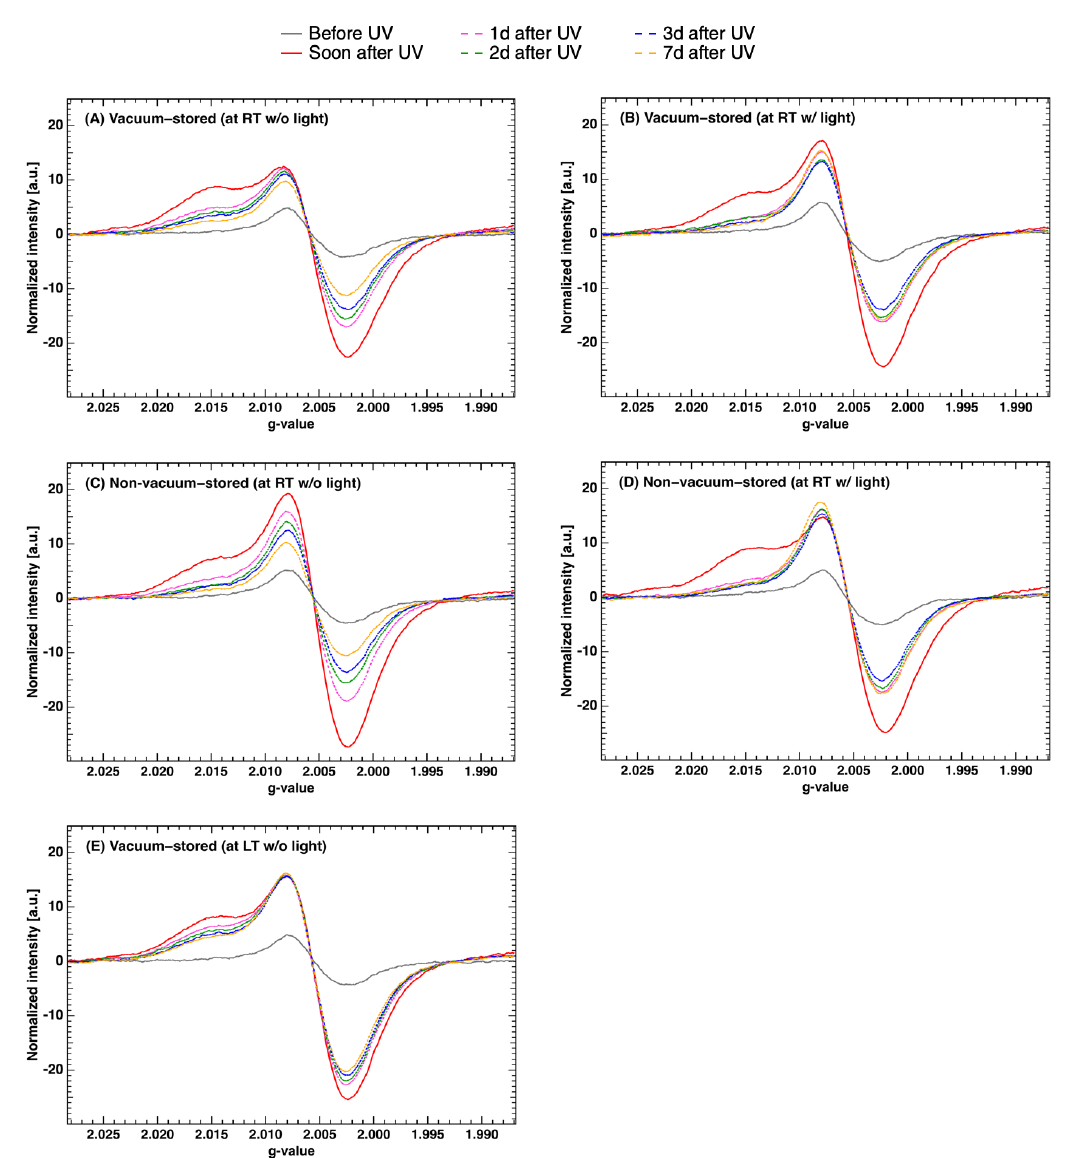
Figure 5. Time evolution of the ESR spectra in unirradiated and untreated samples following UV exposure for 30 min, as described in step 1 of Experiment 2. Each sample set was stored under different storage and location conditions. Each spectrum or datum point was obtained as the average of four subsets. The notations RT, LT, w/light, and w/o light are the same as in Figure 4. Another important finding following UV exposure was the appearance of the “bulge” in the spectra (between g = 2.014 and 2.024), which was described as the resulting